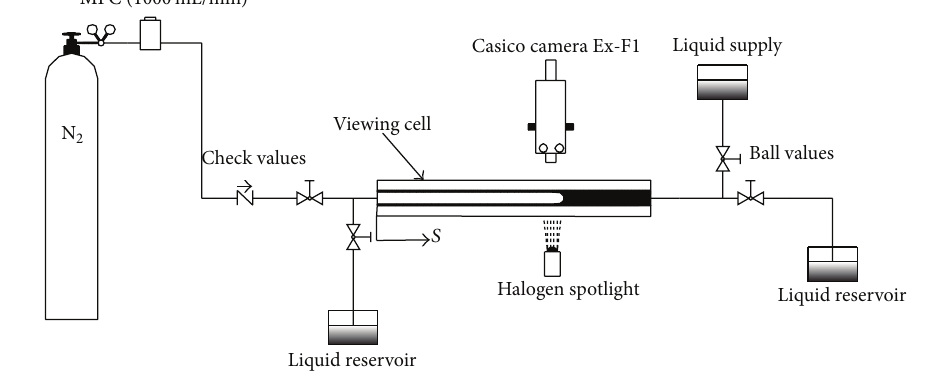
Figure 1: Experimental system.